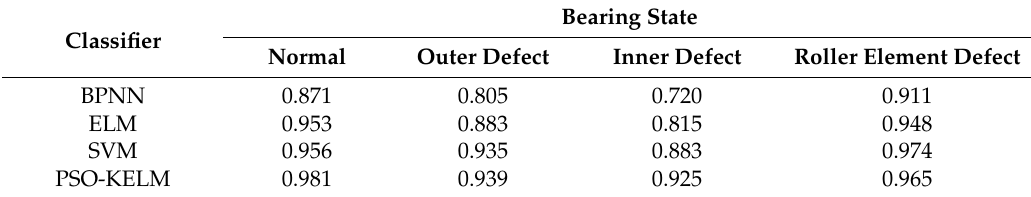
Table 7. Diagnostic results in different operating conditions.